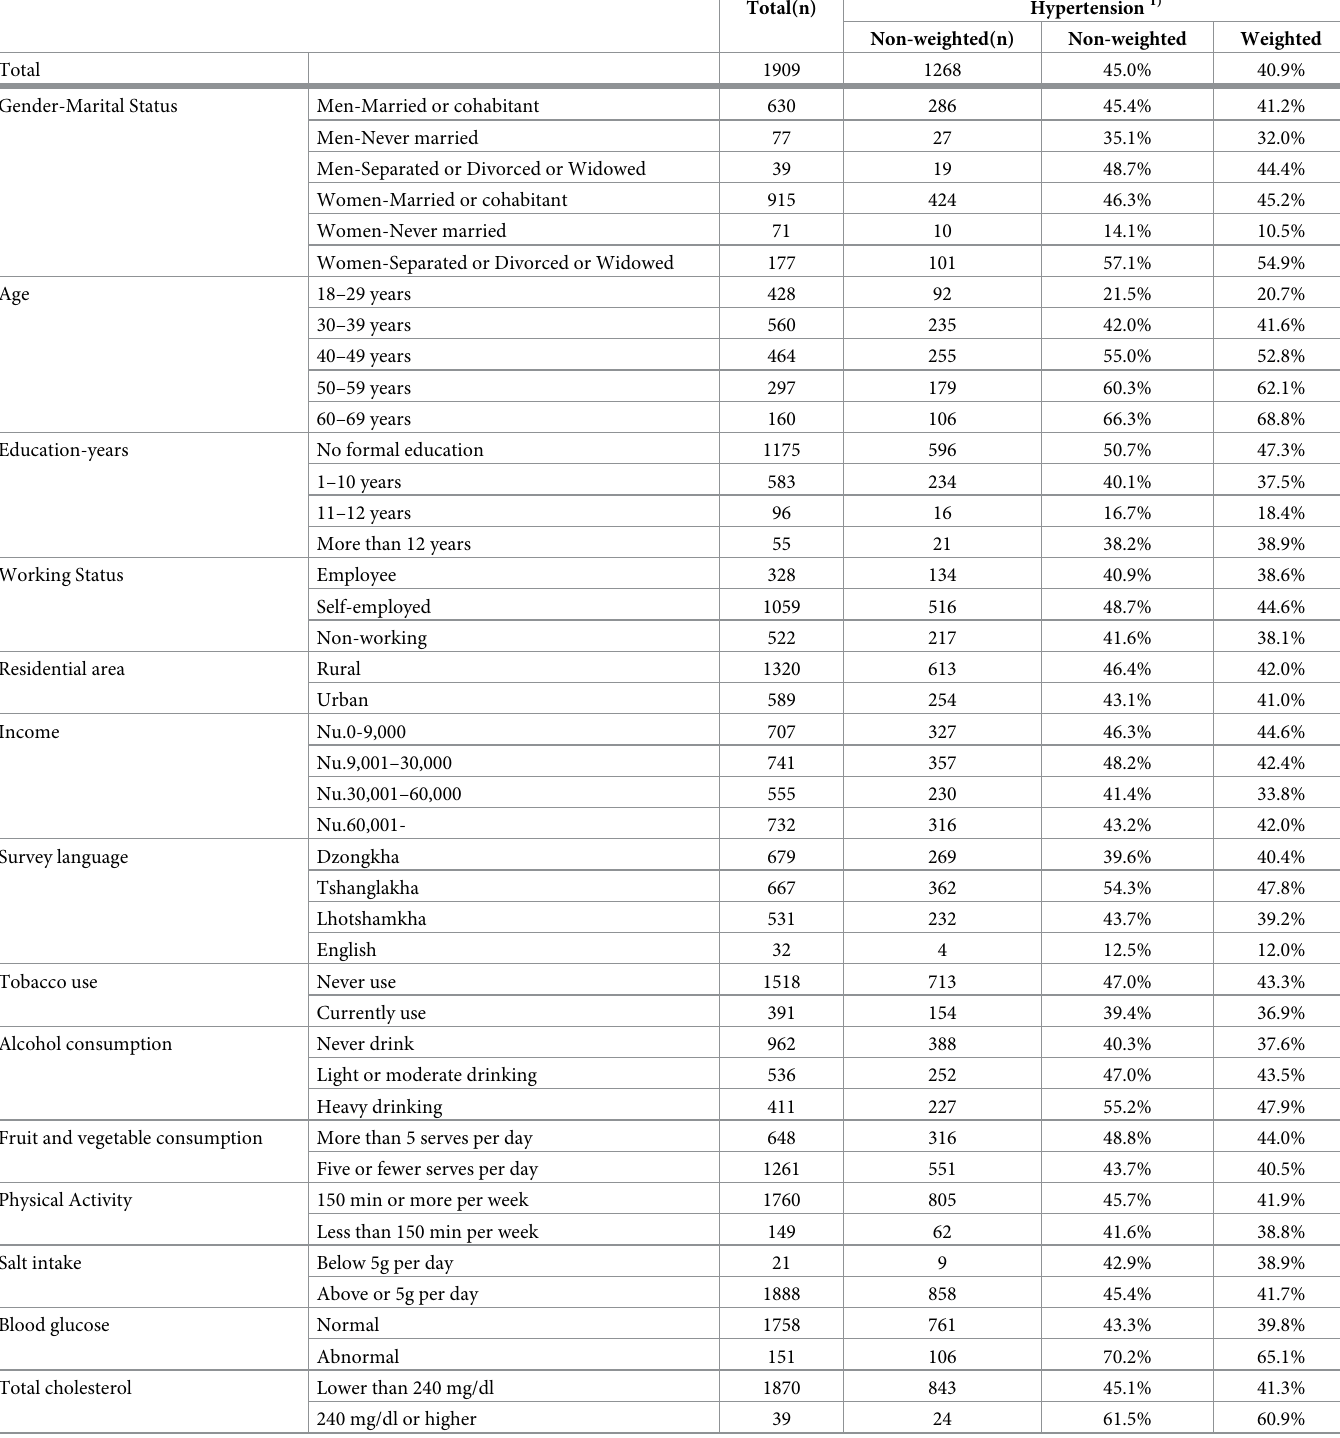
Table 1. Distribution of sociodemographic